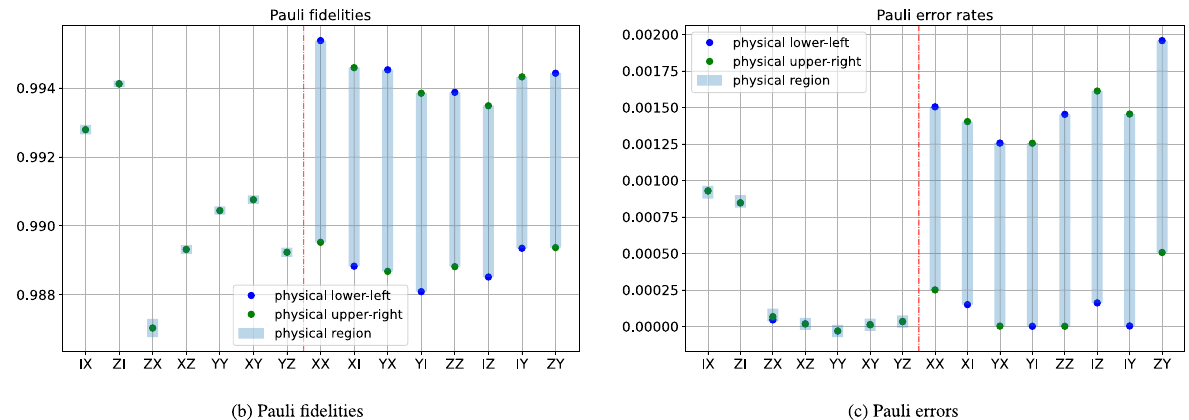
b Feasible region of individual Pauli fi delities. c Feasible region of individual Pauli